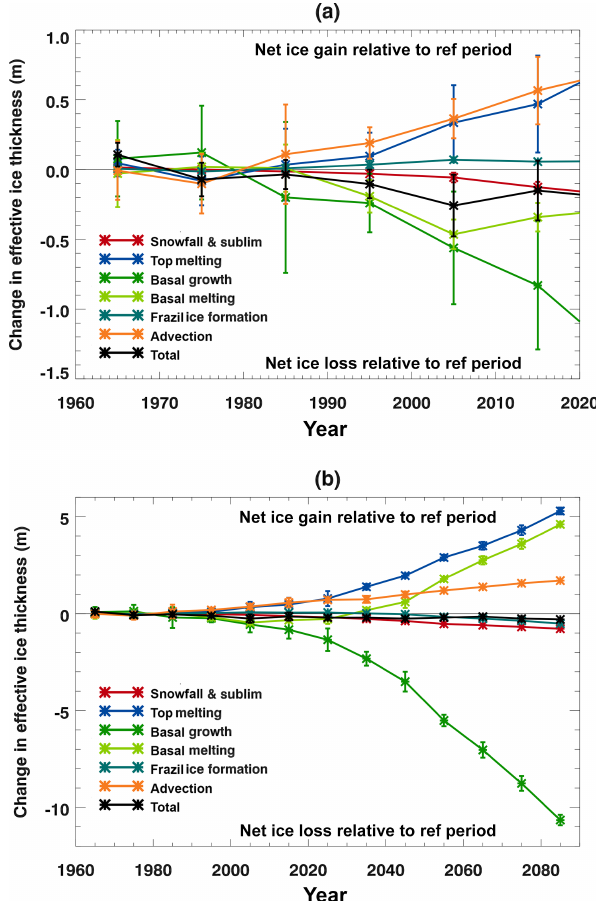
Figure 5. Decadal mean components of the sea ice volume budget as defined in Sect. 3.1 for the HadGEM2-ES Hist + RCP8.5 integra- tions, averaged over the region defined in Fig. 2 and plotted as dif- ferences relative to the mean over the reference period 1960–1989. Values are ensemble means ± 1 standard deviation, and positive val- ues correspond to net ice gain with respect to the reference period: (a) to 2020 (with magnified vertical scale) and (b) to